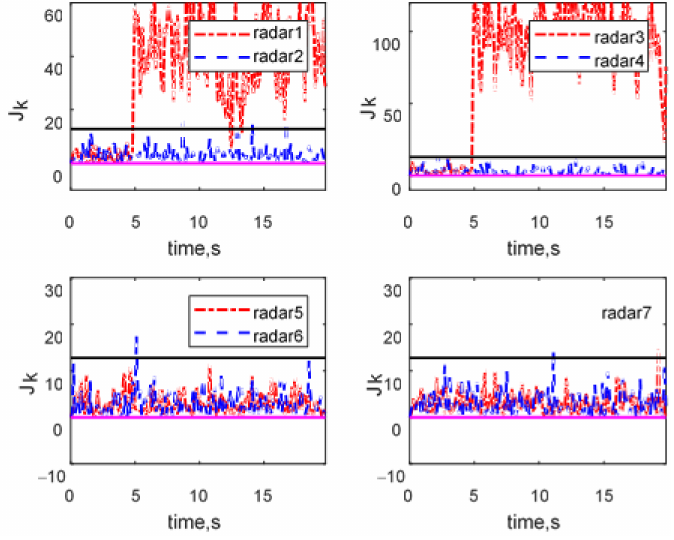
Figure 2. Injected data detection results.